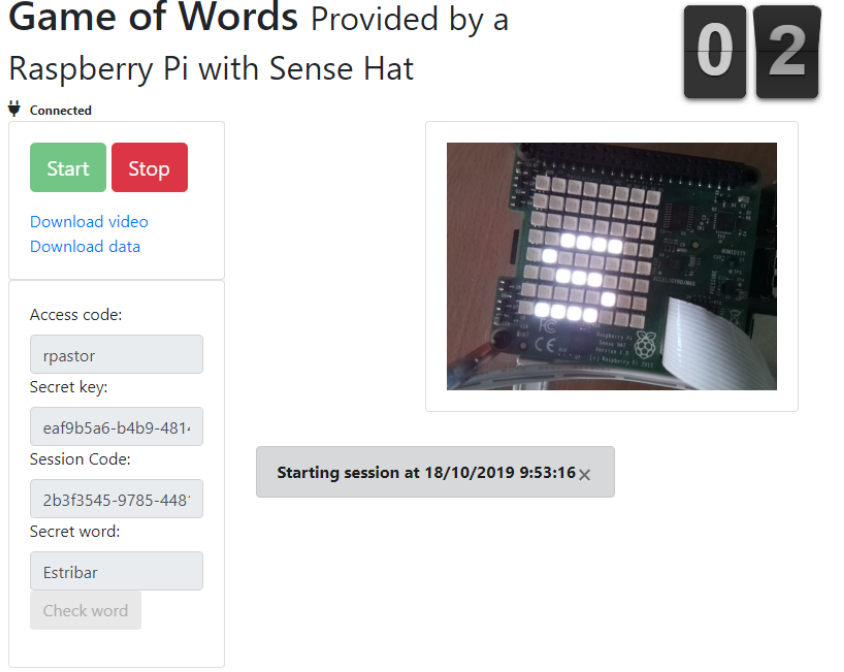
Figure 9. Game of words. IoT devices with sense